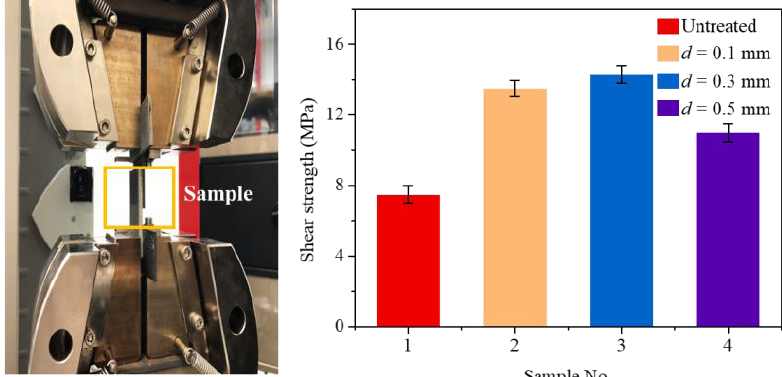
Figure 14. CFRTS-TC4 alloy joint tensile strength test.